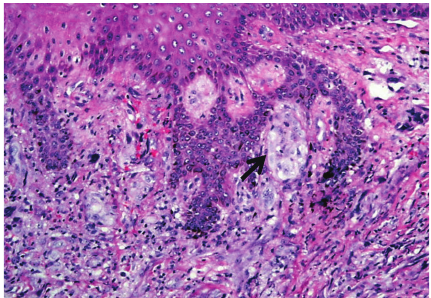
Figure 25: Cutaneous anaplastic large cell lymphoma: low-power magnification showing hyperplastic squamous islands (arrow) asso- ciated proliferation of large neoplastic lymphocytes. (H&E, ×